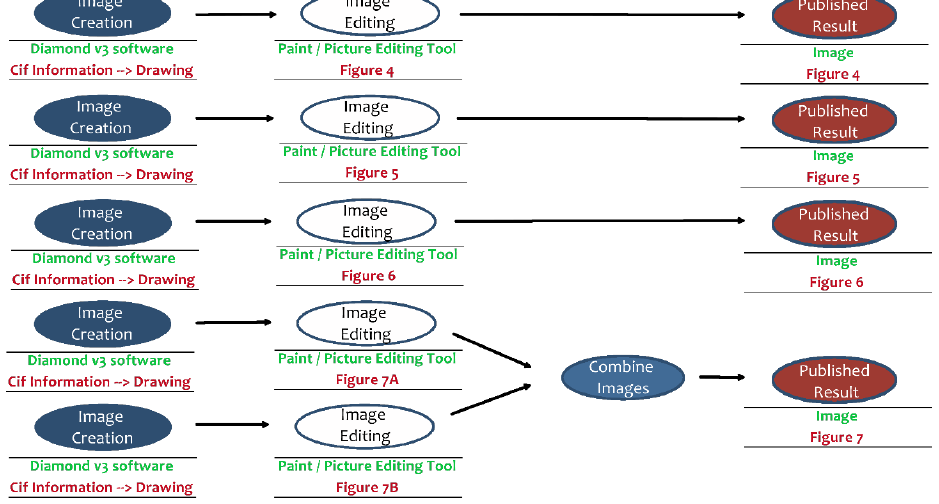
Figure 6. Provenance of published research data for defined publication (Detail: Step 2–5).